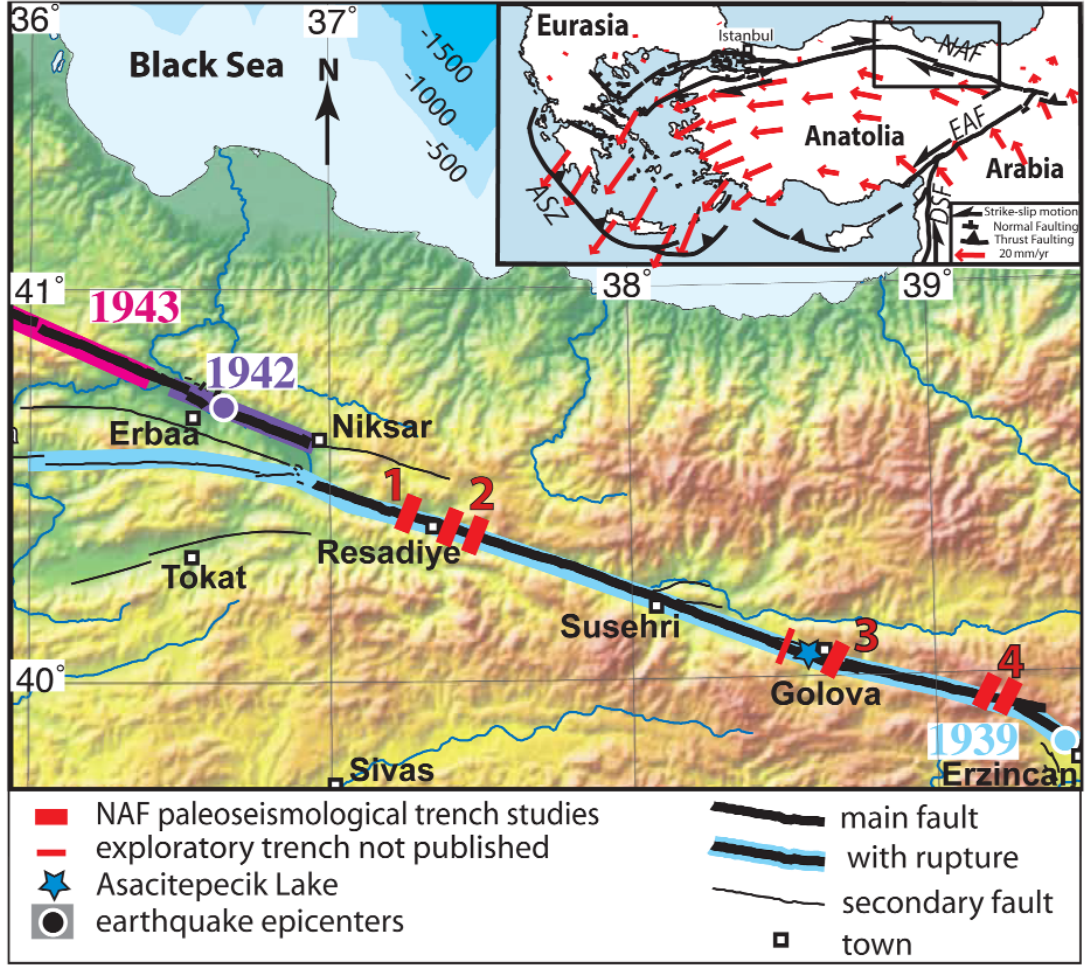
Figure 1. The eastern North Anatolian Fault and its paleoseismological record. 1, site of Fraser et al. [2010]; 2, site of Zabci et al. [2011]; 3, site of Fraser et al. (this volume); 4 site of Hartleb et al. [2006] and Kozacı et al. [2011]. Different colors underlying the main fault trace show ruptures associated with the 1939 M = 7.9 Erzincan earthquake (purple), the 1942 M = 7.1 Niksar-Erbaa earthquake (blue), and the eastern part of the 1943 M = 7.3 Tosya earthquake (pink). Our study focuses on the A ş a ğ ıtepecik Lake (AT Lake, blue star). Inset: Anatolian extrusion accommodated by the North Anatolian Fault (NAF) toward the Aegean Subduction Zone (ASZ), with GPS data from Reilinger et al. [2006] and the location of Figure